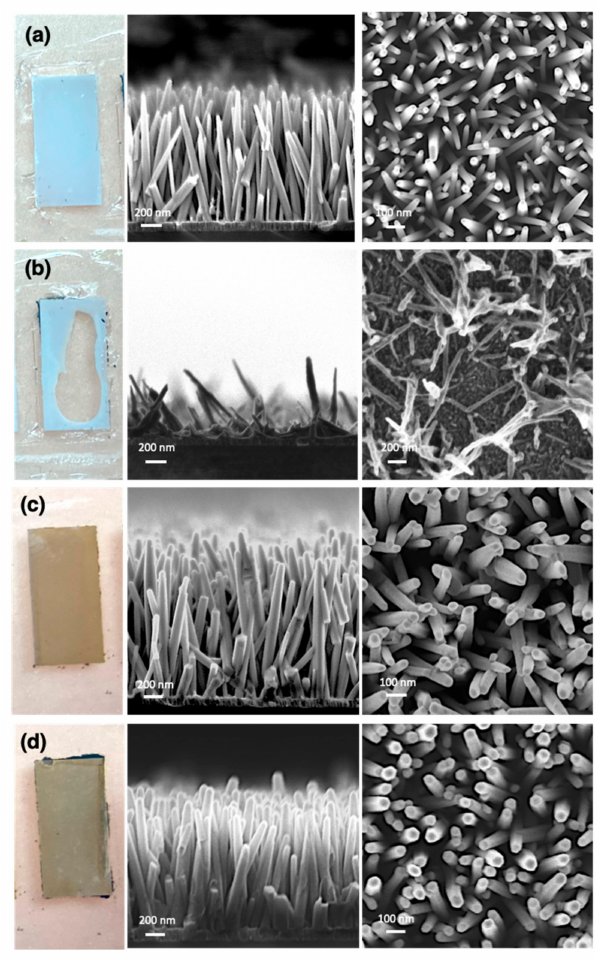
Figure 2. Photos and SEM images. ( a ) Before and ( b ) after supplying blood plasma to the nonannealed ZnO/Al 2 O 3 core-shell nanowires. ( c ) Before and ( d ) after supplying blood plasma to the annealed ZnO/Al 2 O 3 core-shell